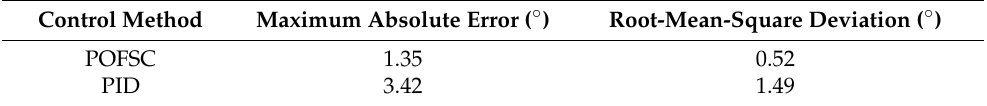
Figure 18. Comparison of fifth-order path-tracking between the POFSC and PID for the elbow joint flexion angle of 75°. ( a ) System response, ( b ) tracking error, and ( c ) control voltage. Table 10. Error comparison using the POFSC and PID for the elbow joint (60°).